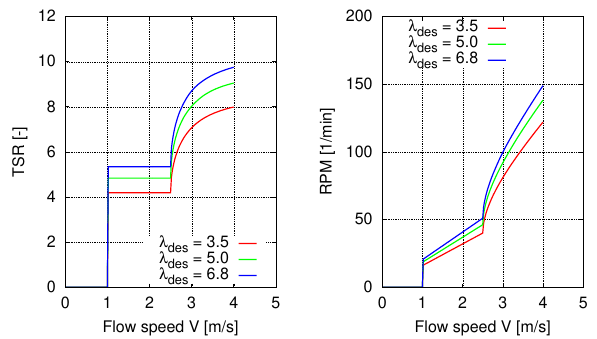
Fig. 28. Full-scale turbine, V des = 2 . 5 m/s: Tip Speed Ratio (TSR, left) and rotational speed (RPM, right) curves as function of flow speed.